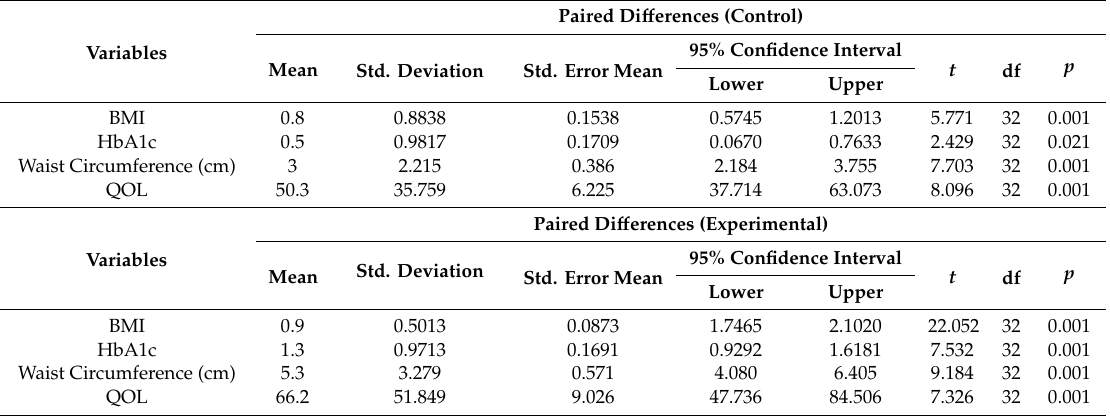
Table 2. Pre-posttest analysis within the group by Paired sample t -test for within-group di ff